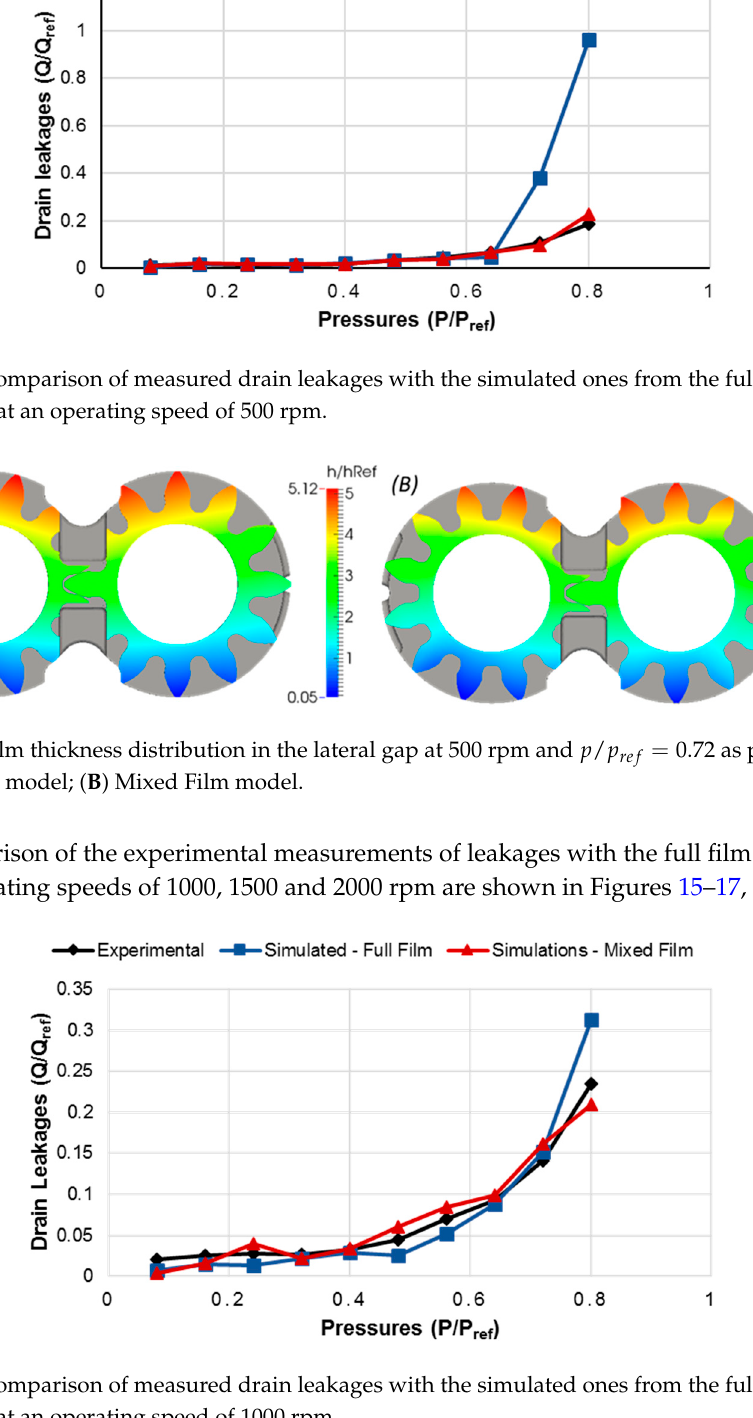
Figure 16. Comparison of measured drain leakages with the simulated ones from the full and mixed film models at an operating speed of 1500 rpm.